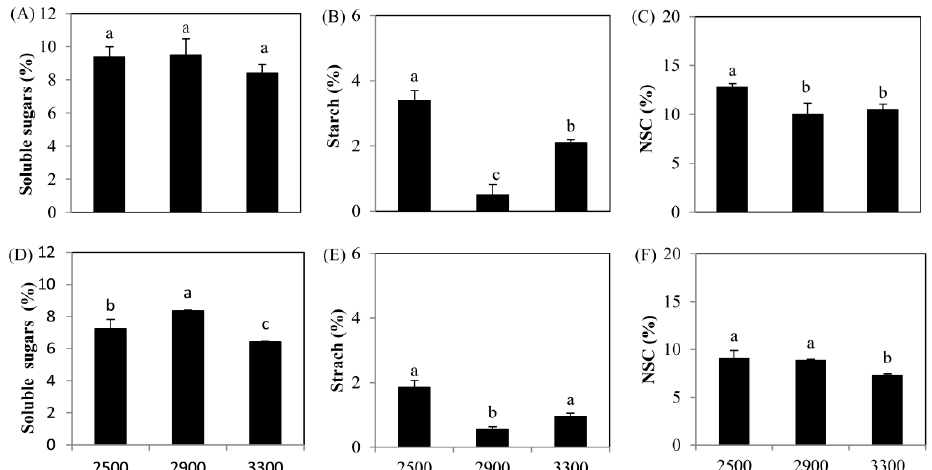
Figure 1. Changes of non-structural carbohydrates of Picea crassifolia with the increasing elevations (m). ( A – C ) Current-year needles; ( D – F ) current-year branches. Different lowercase letters represented the significance levels ( p < 0.05) among the different elevations. NSC: non-structural carbohydrate.